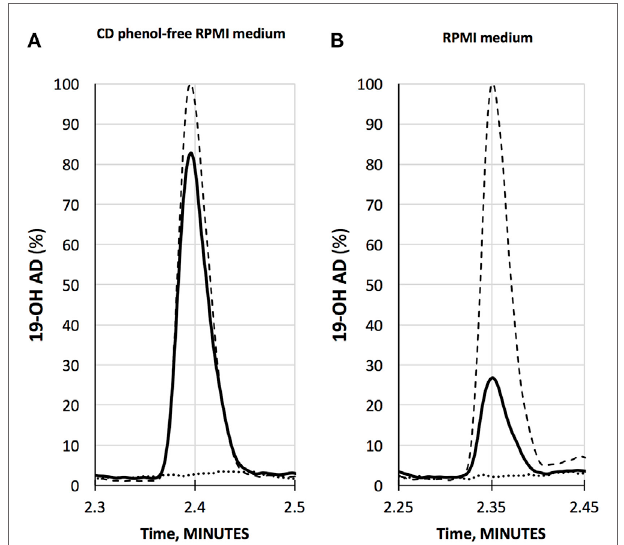
FigUre 2 | Quantification of 19-OH AD by LC-MS/MS in the medium from AFMK-stimulated LNCaP cells. (a) CD phenol-free RPMI medium with 250 μ M acetyl- N -formyl-5-methoxykynurenamine (AFMK) (solid line), 1 ng/mL of 19-OH AD- standard spike (dashed line); estimated concentration of 19-OH AD is 0.83 ng/mL medium. (B) RPMI medium + 250 μ M AFMK (solid line), 1 ng/mL 19-OH AD of standard spike (dashed line); estimated concentration of 19-OH AD is 0.27 ng/mL. Dotted lines at the bottom in A and B are media only, with no AFMK. Curves are normalized to 1 ng/mL 19-OH